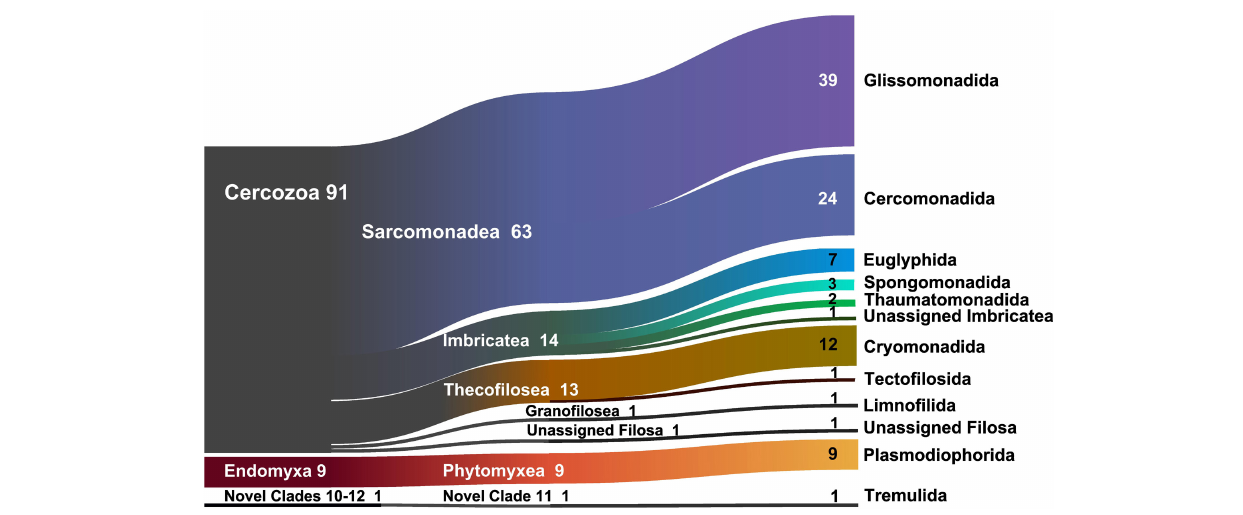
FIGURE 1 | Sankey diagram showing the relative contribution of the OTUs to the taxonomic diversity. Taxonomical assignment is based on the best hit by BLAST. From left to right, names refer to phyla (Cercozoa, Endomyxa), class (ending -ea), and orders (ending -ida). “Unassigned” refer to sequences that could not be assigned to the next lower-ranking taxon or to “incertae sedis” order or families. Numbers are percentages of sequences’ abundances – taxa represented by < 1% are not shown.